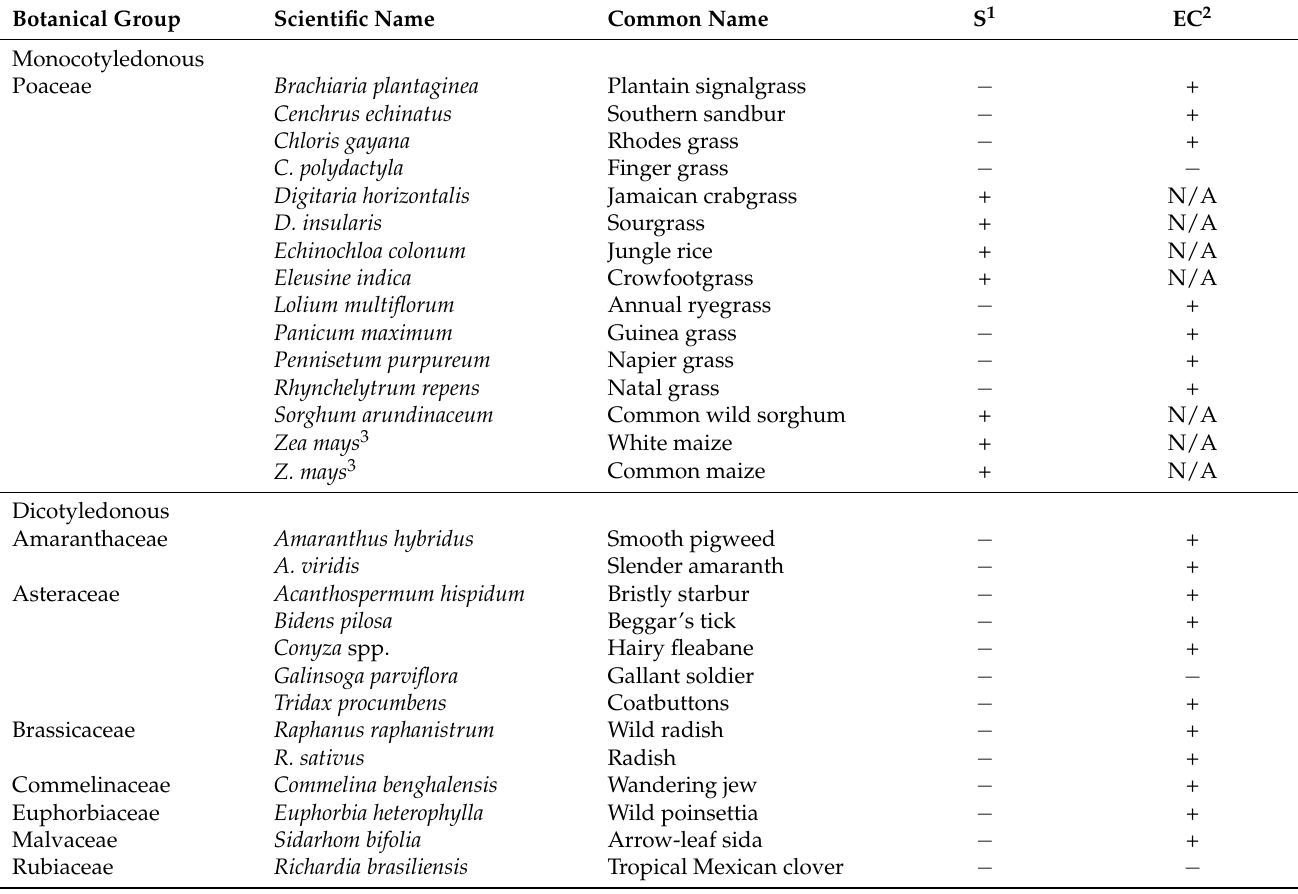
Table 3. Pathogenicity and epiphytic colonization of Xanthomonas vasicola pv. vasculorum ( Xvv ), the causal agent of bacterial leaf streak (BLS) of maize, in